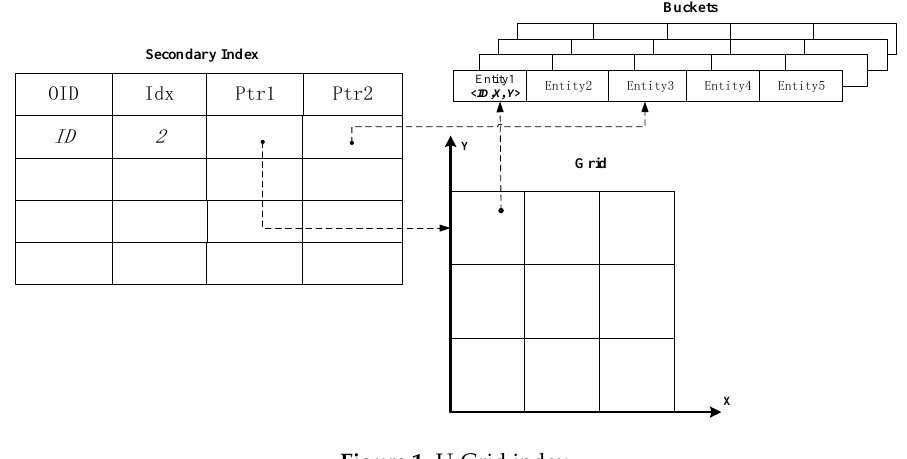
Figure 1. U-Grid index.